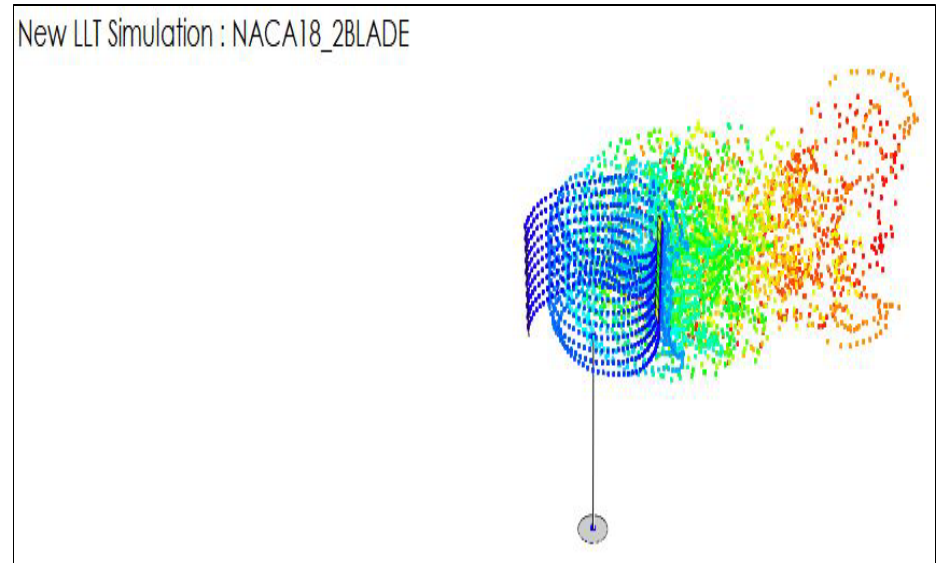
Figure 48. Two-bladed vortex simulation 2